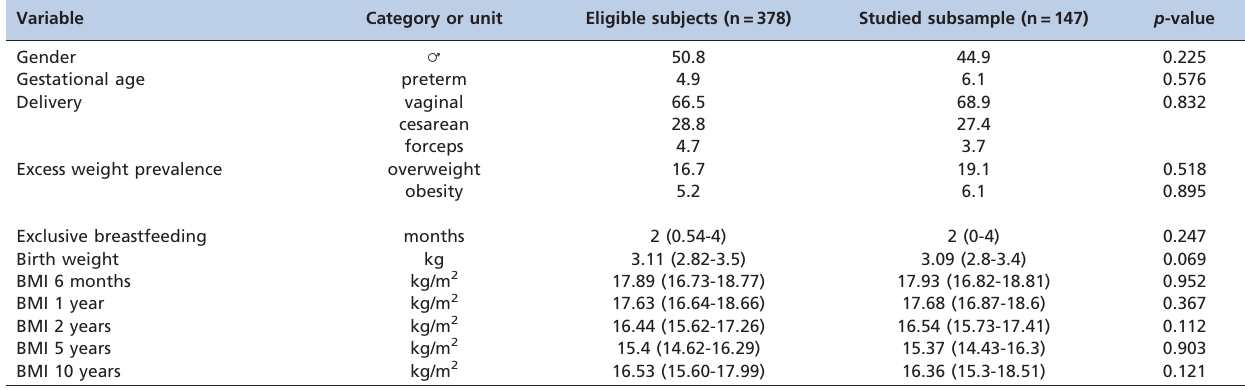
Table 1 - Description of the characteristics of the eligible population and the studied subsample.